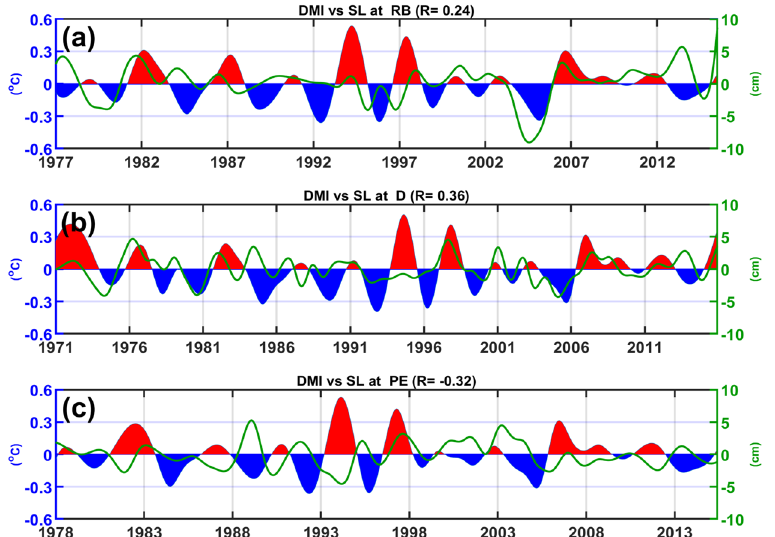
Figure 6. Time series of interannual Dipole Mode Index (DMI) and SL records at ( a ) Richards Bay, ( b ) Durban and ( c ) Port Elizabeth. DMI in degrees Celsius is given in blue and SL in centimeters is given in green. Correlation coefficients are found in the panel titles.